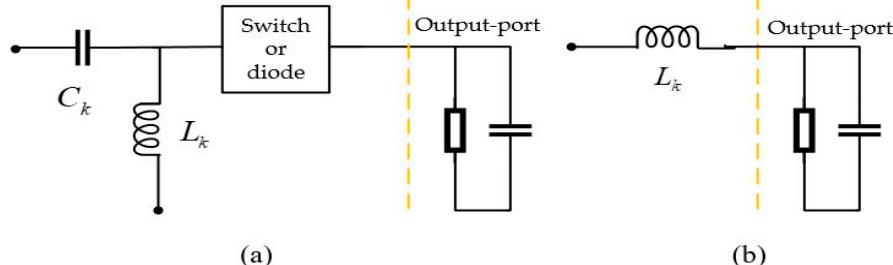
Figure 12. ( a ) First circuit configuration 𝑨 𝟏 = 0 , ( b ) second circuit configuration rule for 𝑨 𝟏 = 0 .